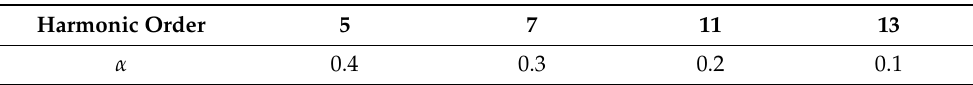
Table 2. Weight of each harmonic voltage.